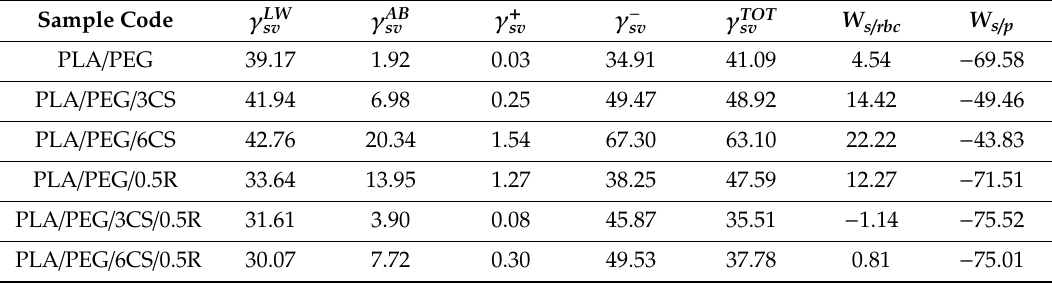
Table 7. Surface free energy (mN / m) of PLA / PEG-based samples containing chitosan and powdered rosemary ethanolic extract and work of spreading ( W s ) for red blood cells (rbc) and platelets (p). Sample Code